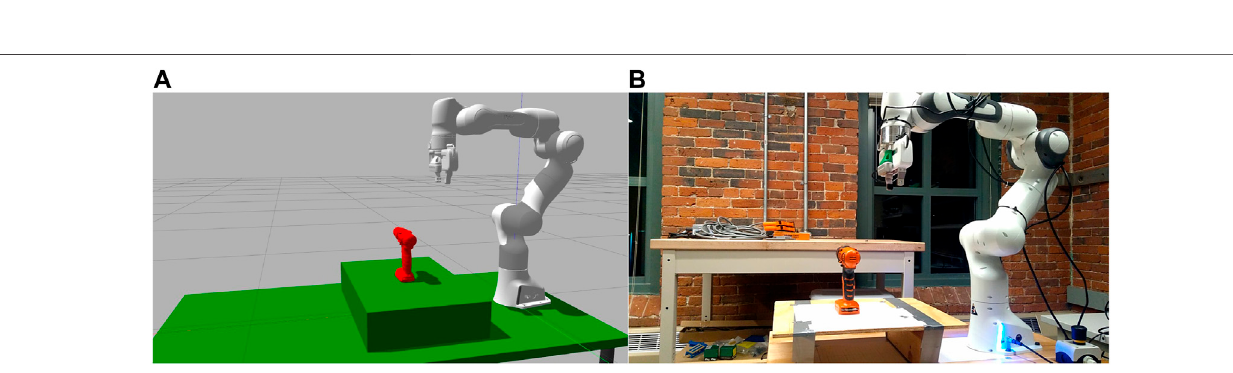
FIGURE 8 | The setup as seen in simulation environment (A) and lab environment (B) with the power drill object in place.